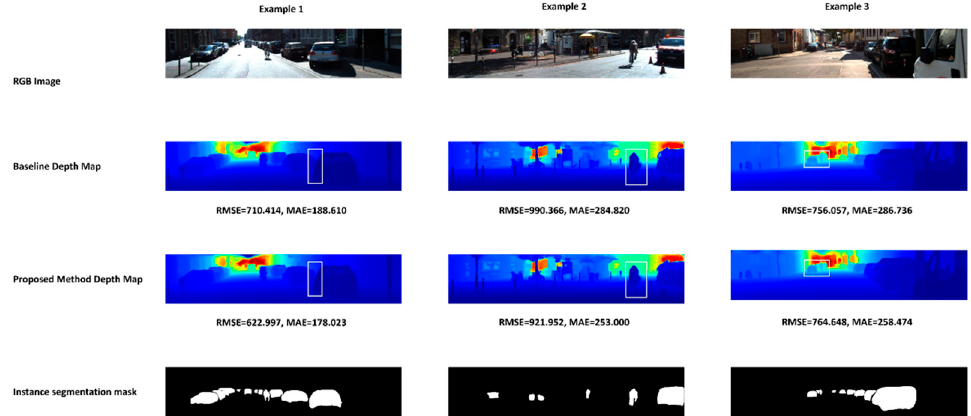
Figure 15. Qualitative results for randomly selected samples. The white rectangle inside depth maps images indicates the interesting areas.